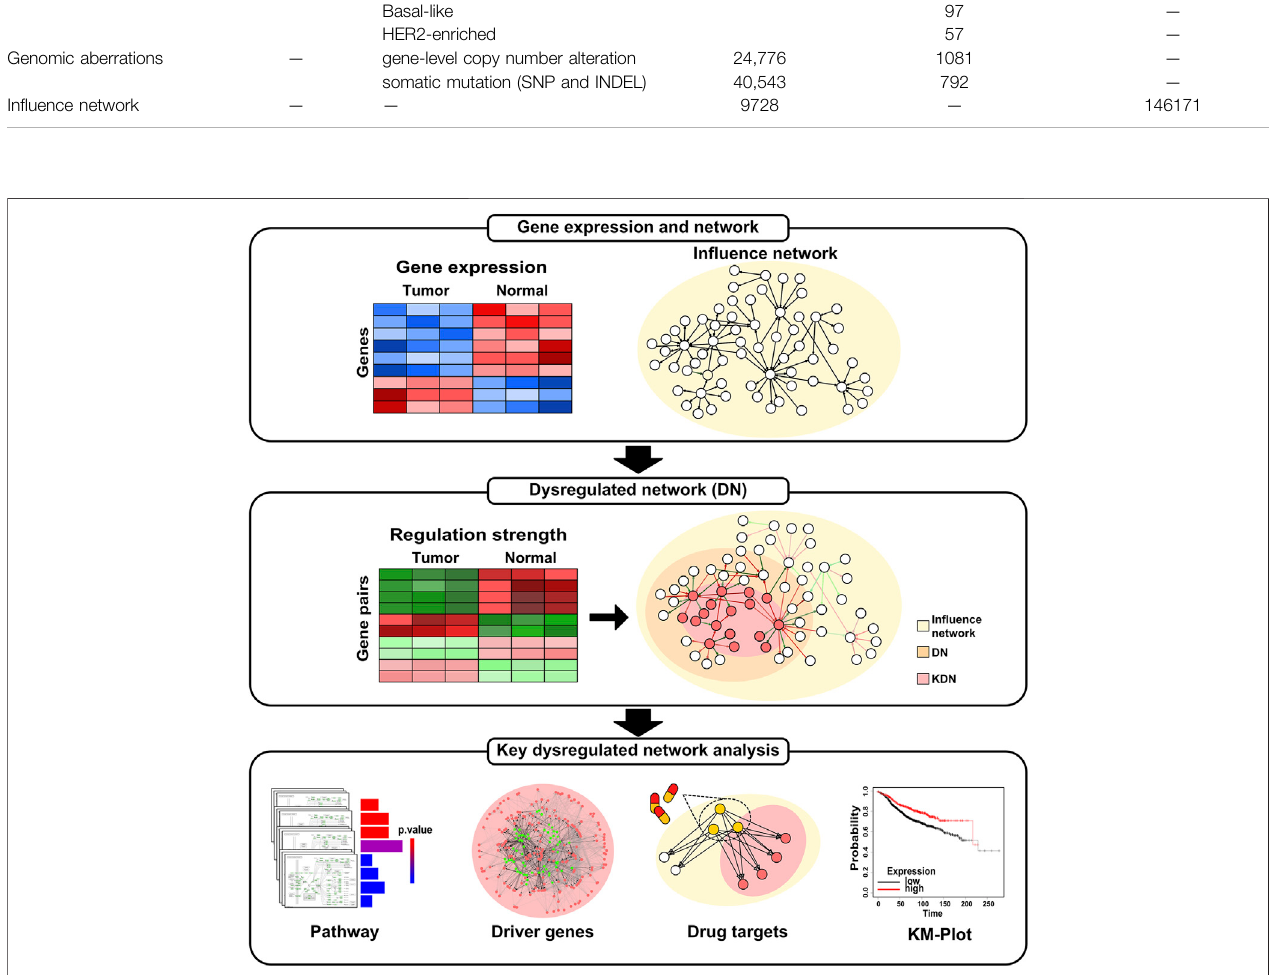
FIGURE 1 | Overview of the analysis work fl